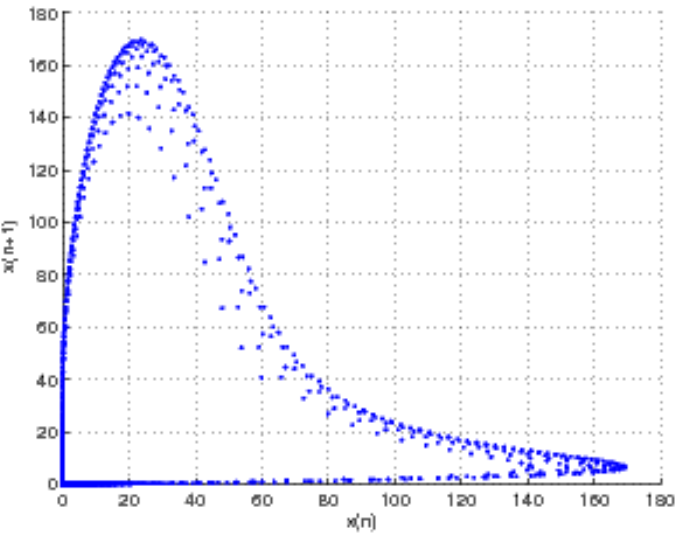
Figure 4. Phase portraits of the map x n + 1 = 0.8999 x n + x n − 4 /1.1103 + x n − 1 , for B = B ∗